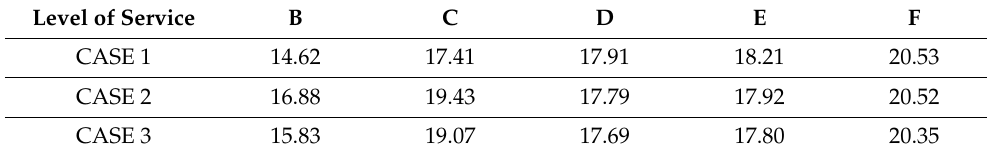
Table 6. CO 2 emission (kg/veh).